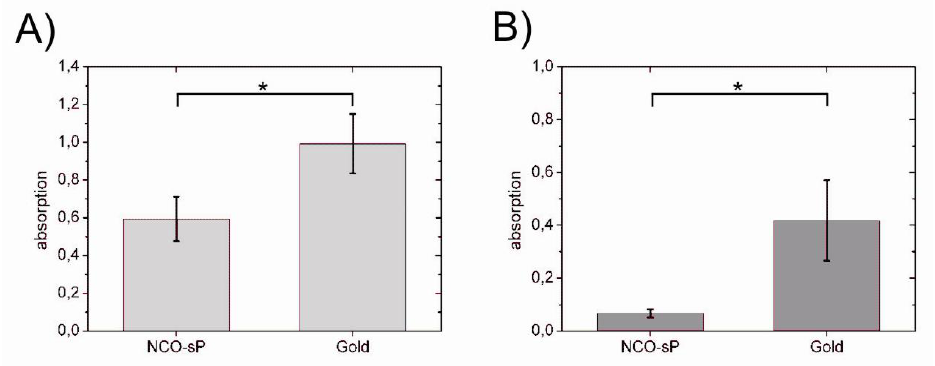
Figure 3. Modified ELISA tests for fibrinogen adsorption from 0.5 mg/mL fibrinogen solution ( A ) und 1 + 4 diluted human PPP ( B ). Differences between groups were calculated by univariate analysis of variance (n = 3 for each group). Values of p < 0.05 were considered as significant and marked with